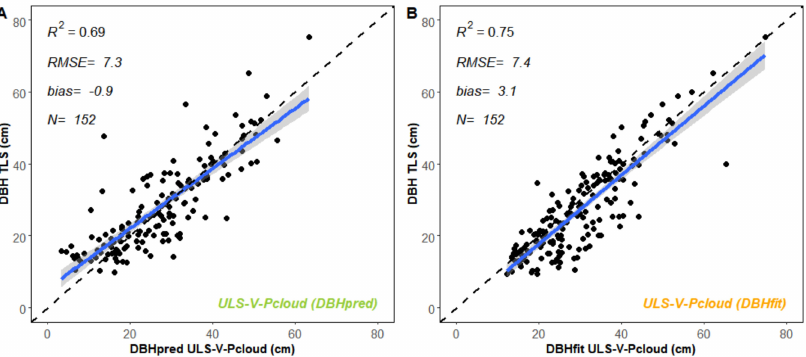
Figure 14. Comparison of the estimated DBH from ULS-V-Pcoud using ( A ) predictive modeling approach (DBH pred ) and ( B ) cylinder fitting approach (DBH fit ). Both estimates used the same trees that were delineated from SimpleTree (N = 152) against their paired reference trees (DBH TLS ).